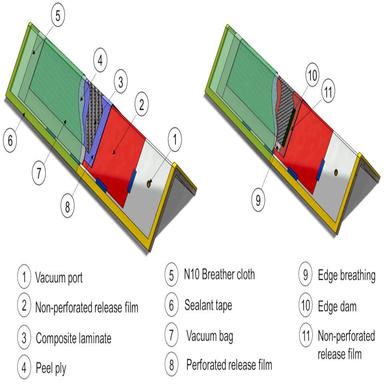
Debulking (left) and curing (right) manufacturing schematics for the L-shape laminates along with the item list. (For interpretation of the references to colour in this figure legend, the reader is referred to the web version of this article.)